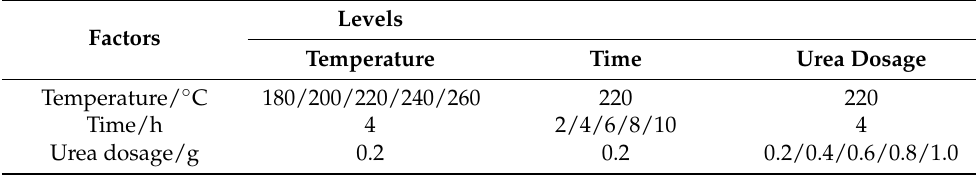
Table 2. Design of single-factor experiments for N-CQD preparation